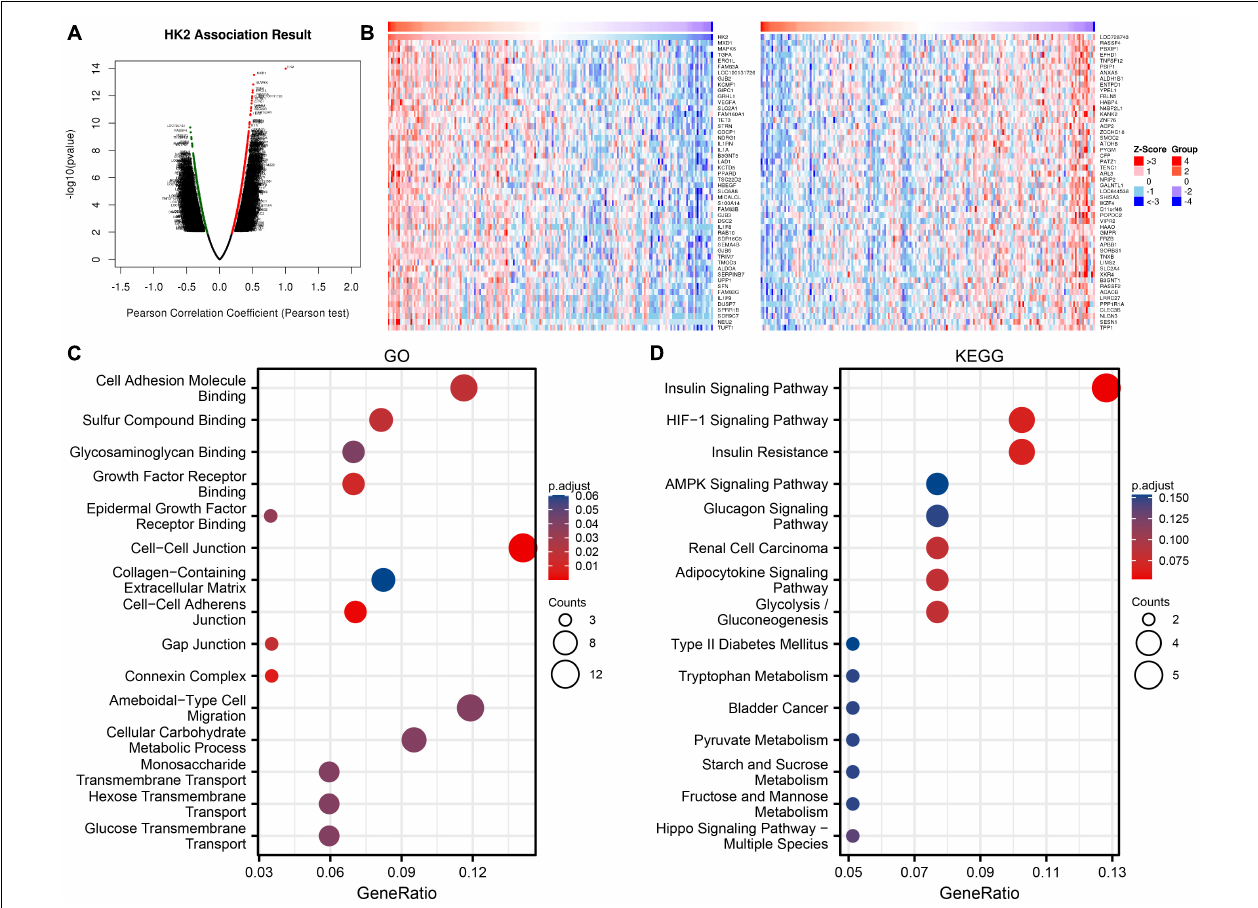
FIGURE 3 | Enrichment analysis of HK2 gene co-expression network in esophageal carcinoma (ESCA). (A) The co-expressed genes related to HK2 expression in TCGA ESCA cohort were shown by volcanic map. (B) The first 50 co-expressed genes positively and negatively correlated with HK2 expression were shown by heat map. (C) Enrichment of gene ontology (GO) terms for HK2 co-expression genes. (D) Enrichment of Kyoto Encyclopedia of Genes and Genomes (KEGG) terms for HK2 co-expression